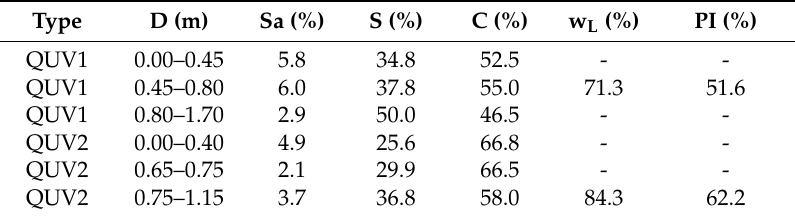
Table 2. Selected geotechnical and physical properties of Santa Maria della Versa test-site soil and weathered bedrock 1 .